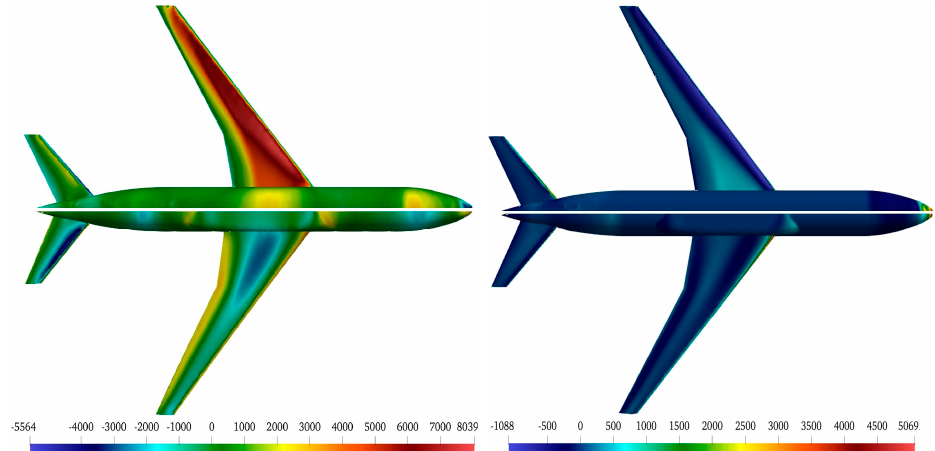
Figure 7. CRM aircraft in cruise flight condition S 1 (M = 0.85 at 44,000 ft) with an angle-of-attack α = 2.05 ◦ . Distribution of the lift ( left ) and drag ( right ) forces (in Newtons) exerted on the suction (( top ) halves) and pressure (( bottom ) halves) sides of the